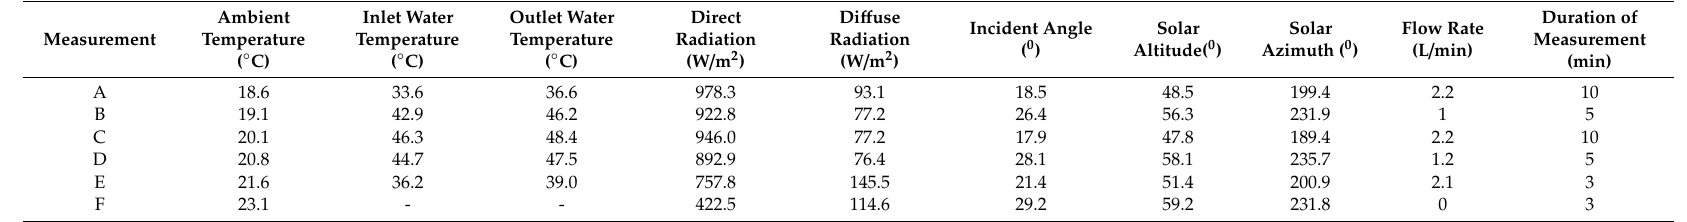
Table 4. Di ff erent parameters of each